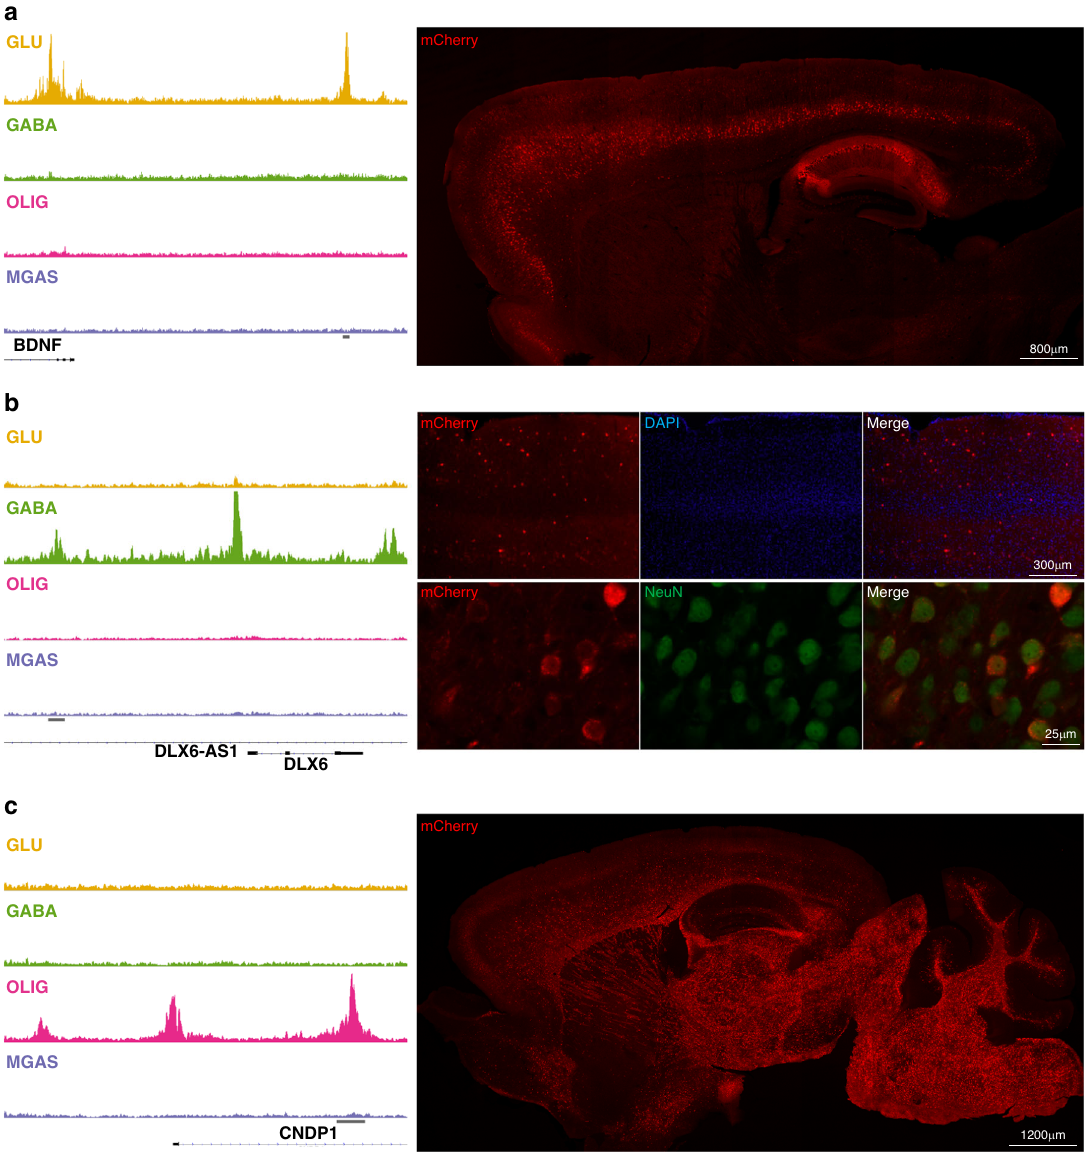
Fig. 4 Transgenic evaluation of putative cell-type-speci fi c enhancers. Left column: Cell-type-speci fi c OCRs identi fi ed by ATAC-seq and nearby genes: ( a ) glutamatergic ( BDNF ), ( b ) GABAergic ( DLX6 ), and ( c ) oligodendrocytes ( CNDP1 ). The horizontal gray bars denote OCR assayed in directed transcription via transgenesis. Right: Representative immuno fl uorescent images showing mCherry (red) expression in 30 µ m thick sagittal sections from ( a ) BDNF and ( c ) CNPD1 transgenic mice. In ( a ), speci fi c mCherry expression is identi fi ed in Layer V of the cortex and in hippocampus. In ( b ) representative images of mCherry (red) staining in the cortex of DLX6 transgenic mice (top panel) and double labeling with NeuN (green; bottom panel), showing expression restricted to neurons and scattered in the cortex, similar to the distribution of GABAergic interneurons. In ( c ) mCherry expression is shown to be restricted to white matter. Four image frames of three independent brain slices per each mouse were analyzed (BDNF enhancer n = 5; DLX6 enhancer n = 6; CNDP1 enhancer n =